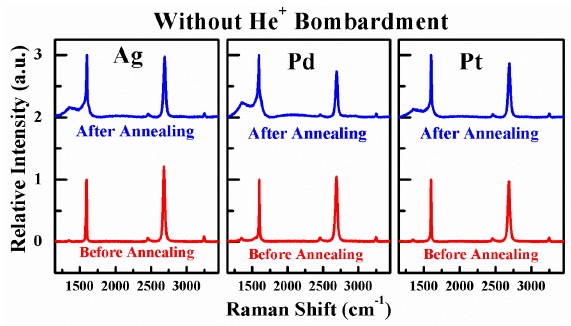
Figure 6. The Raman spectra of the graphene in the G-M contact windows before and after annealing.